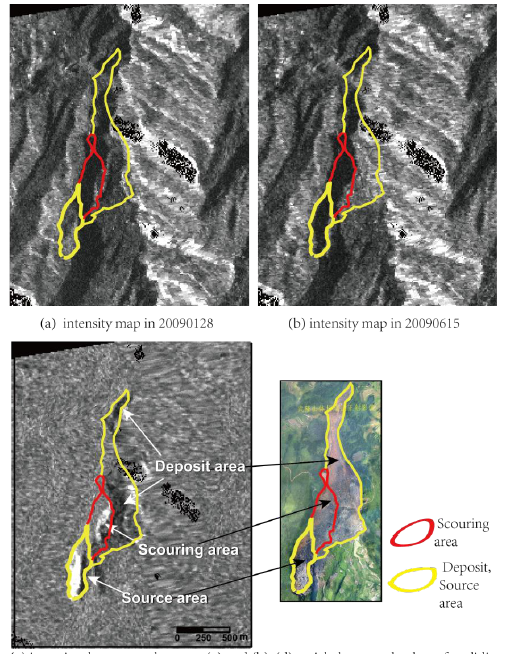
Fig. 8. Two SAR Intensity images acquired on 28 January 2009 (a) and 15 June 2009 (b) . (c) Intensity change map between (a) and (b) . Dashed polygon is superimposed on each map onto indicate the affected area inferred from (d) aerial photograph taken after sliding. In (c) and (d) , source area, scouring area and deposit area are all